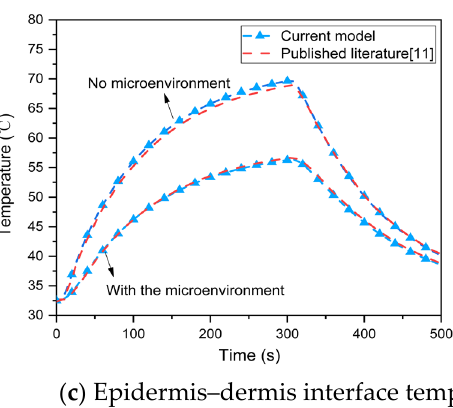
Figure 6. Comparison between the temperature at epidermis–dermis interface predicted by the cur- rent model and the published literature [17].